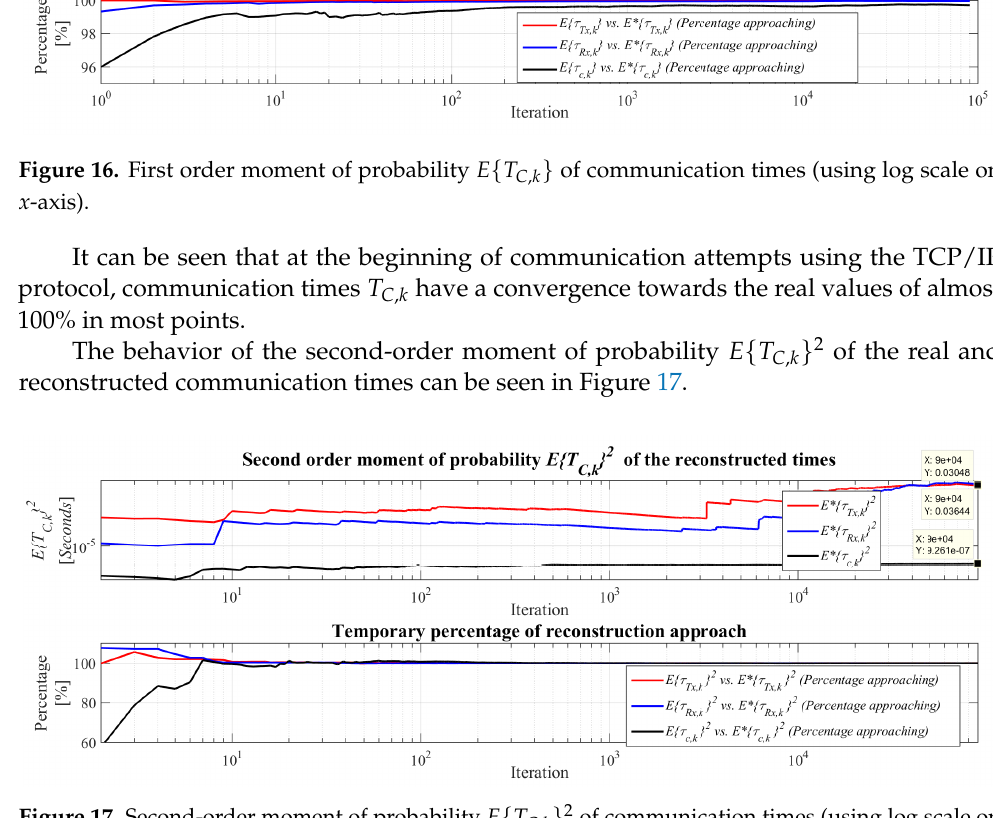
Figure 17. Second-order moment of probability E { T C , k } 2 of communication times (using log scale on x